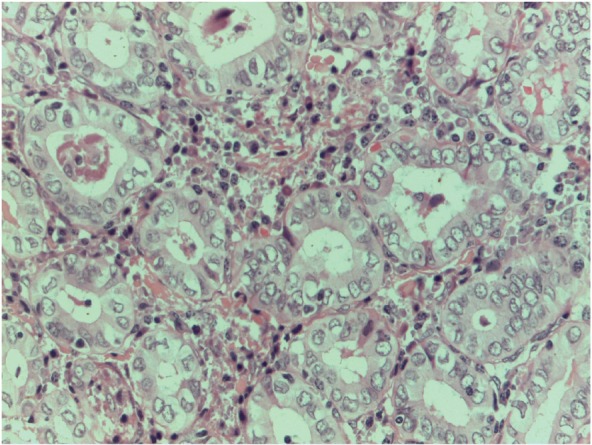
Papillary carcinoma cytoarchitectural features particular x400 magnification.